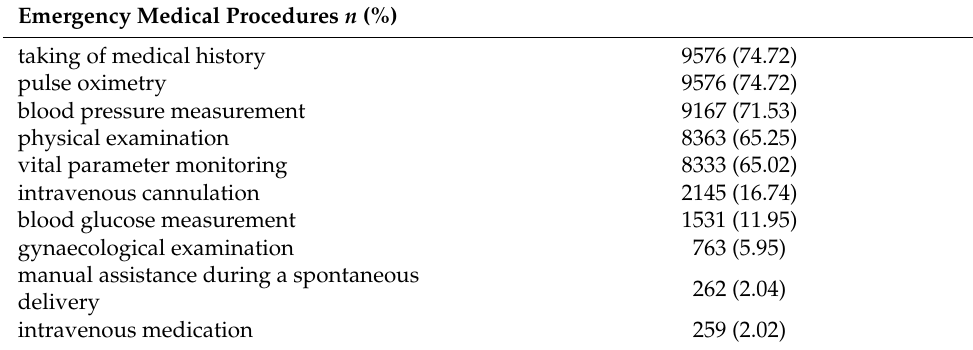
Table 3. Characteristics of the emergency medical procedures performed by EMS teams and selected physical examination